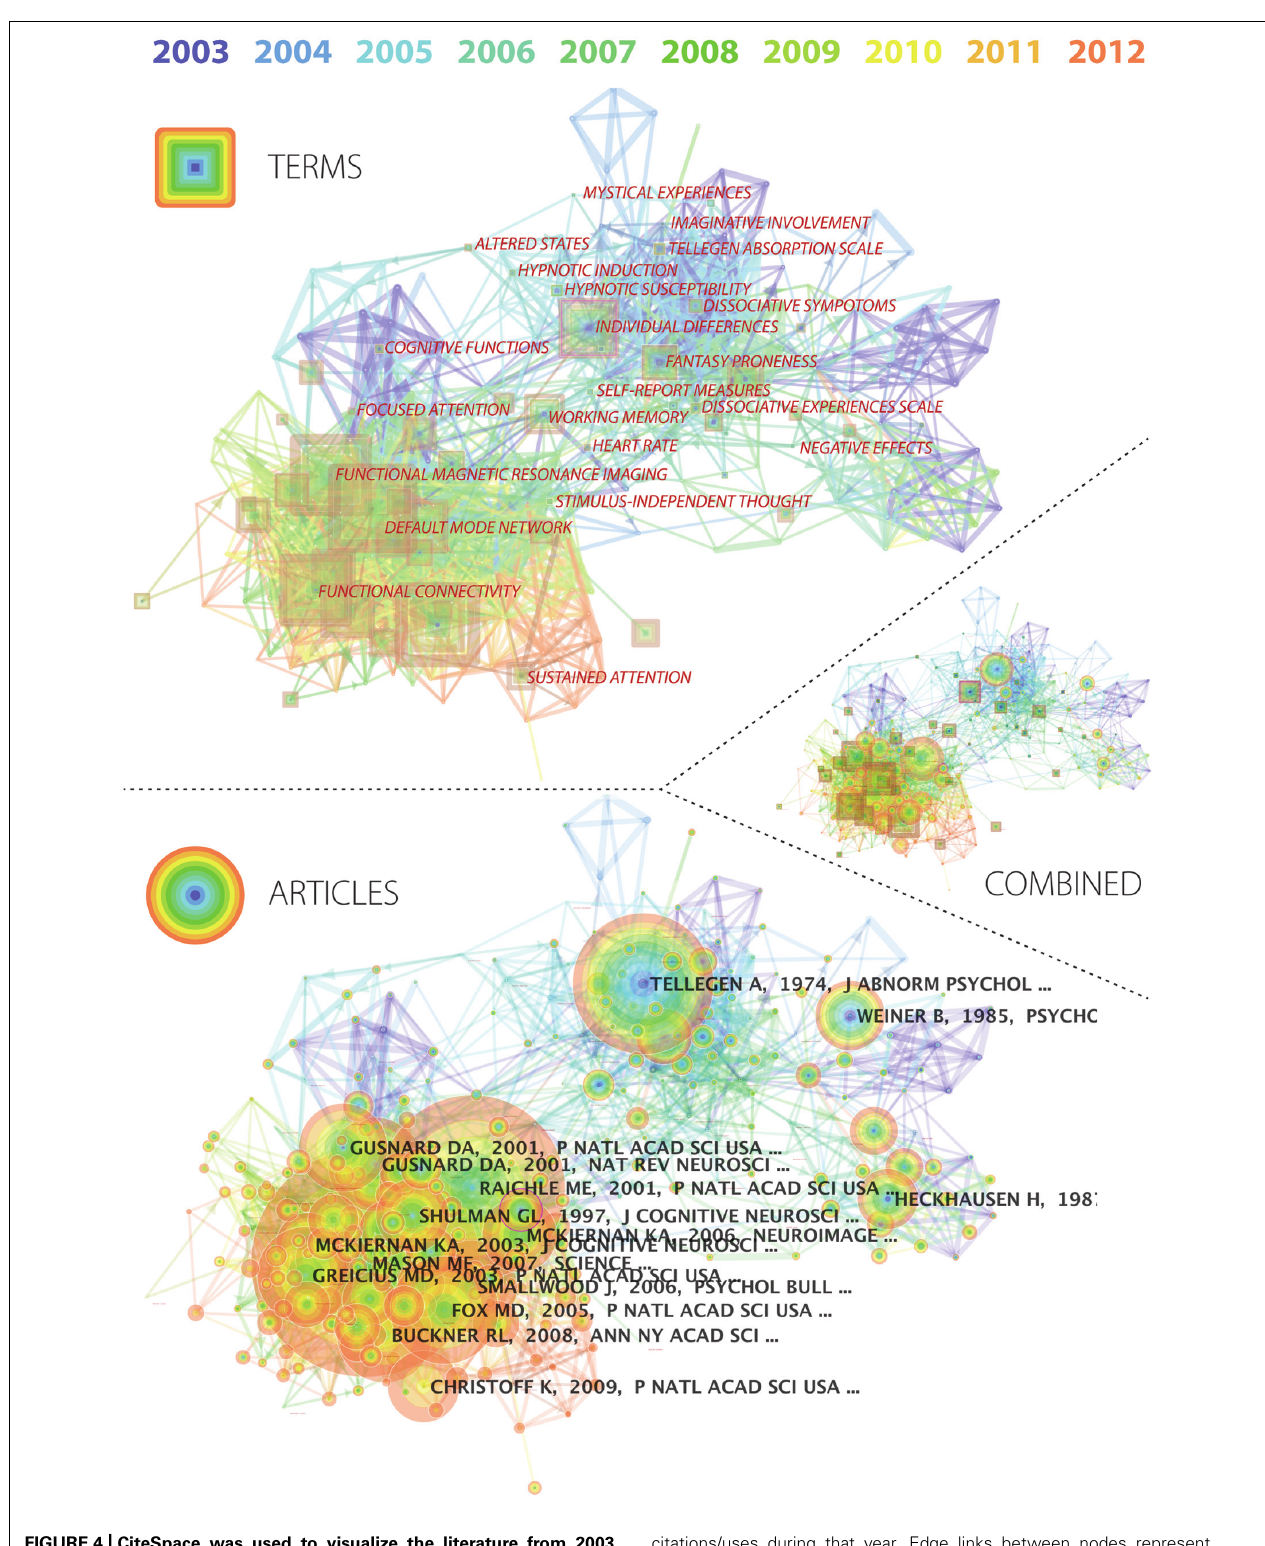
FIGURE 4 | CiteSpace was used to visualize the literature from 2003 to 2012 presented in Figure 1. The colors represent years, the squares are highly used terms ( top ), and the circular nodes are cited articles ( bottom ). Each colored circle represents the number of